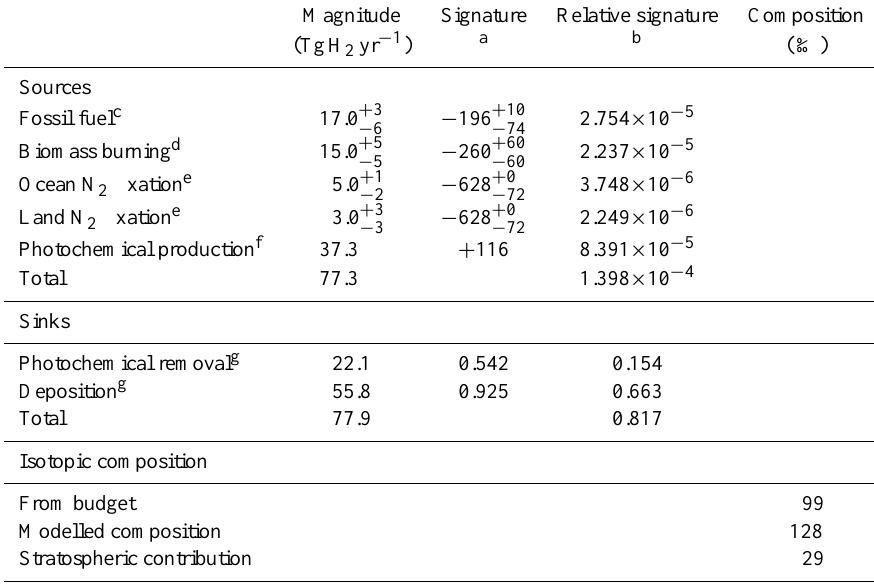
Table 2. Global isotope budget of H 2 up to